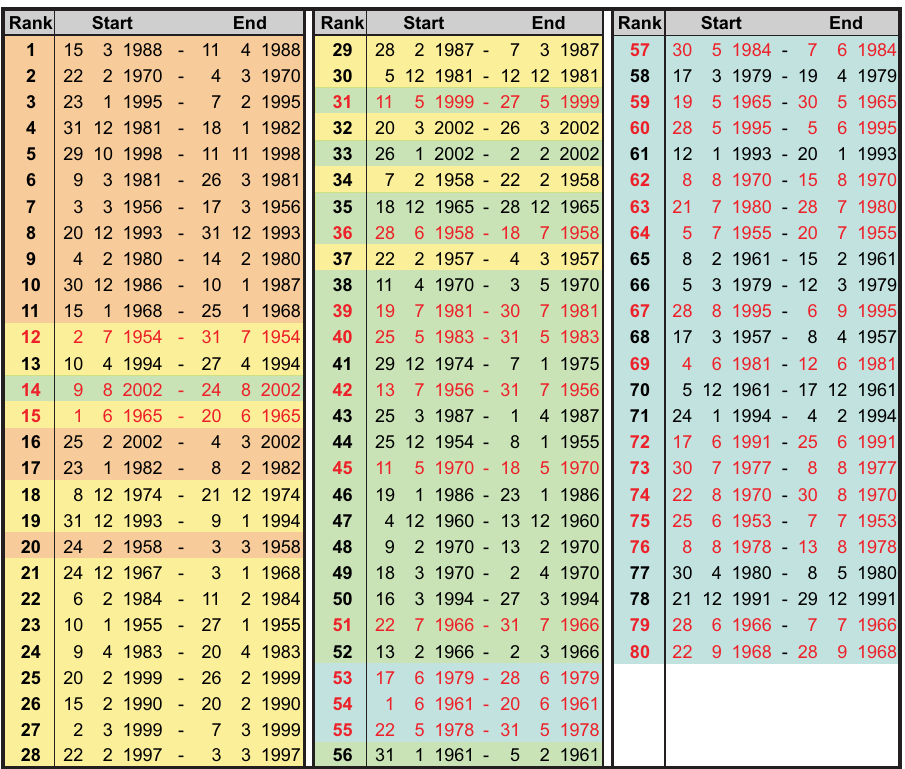
Table 2. List of trans-basin flood events in the period 1952–2002. Classes of spatial extent are highlighted in orange (class 1, L ≥ 50%), yellow (class 2, 50% > L ≥ 33%), green (class 3, 33% > L ≥ 20%) and blue colours (class 4, 20% > L ≥ 10%). Winter events are displayed in black fonts, summer events in red